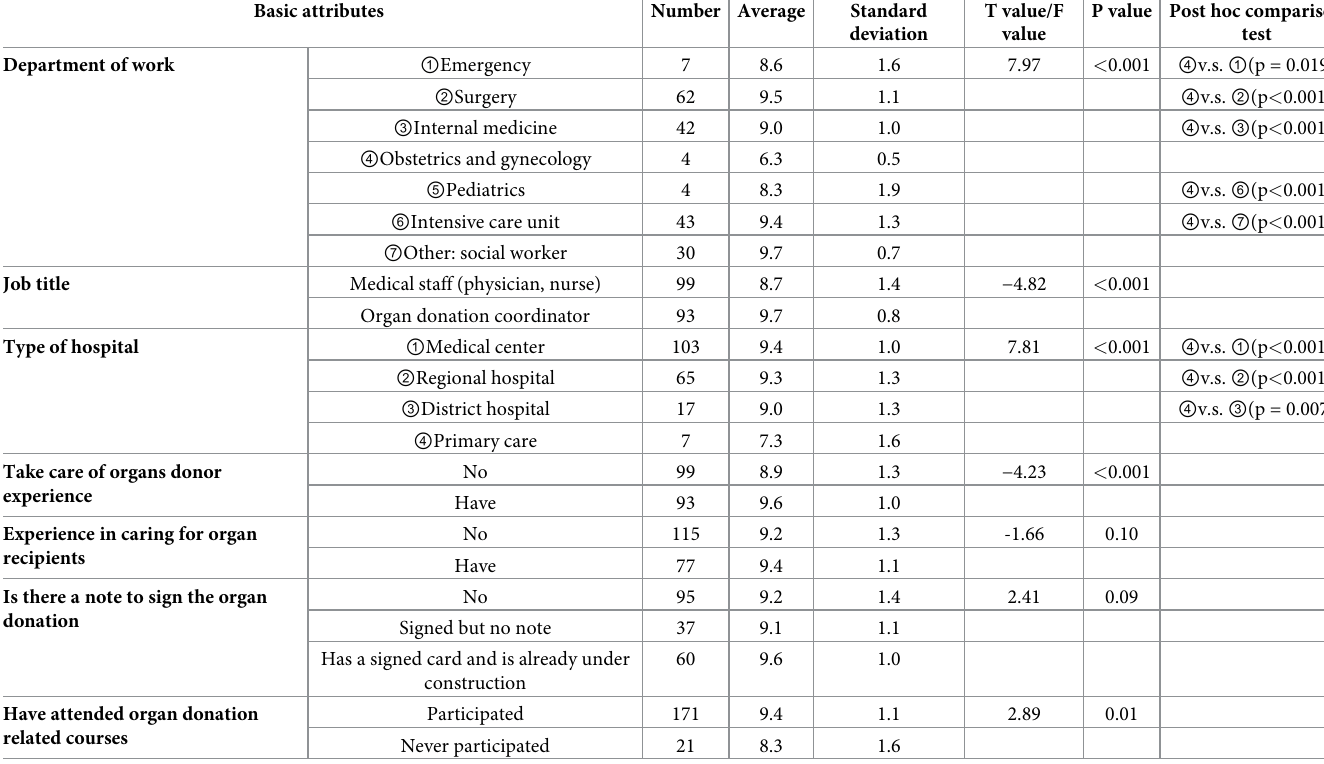
Table 2. Factors related to participants’ basic attributes and knowledge of organ donation behavior ( N = 192). Basic